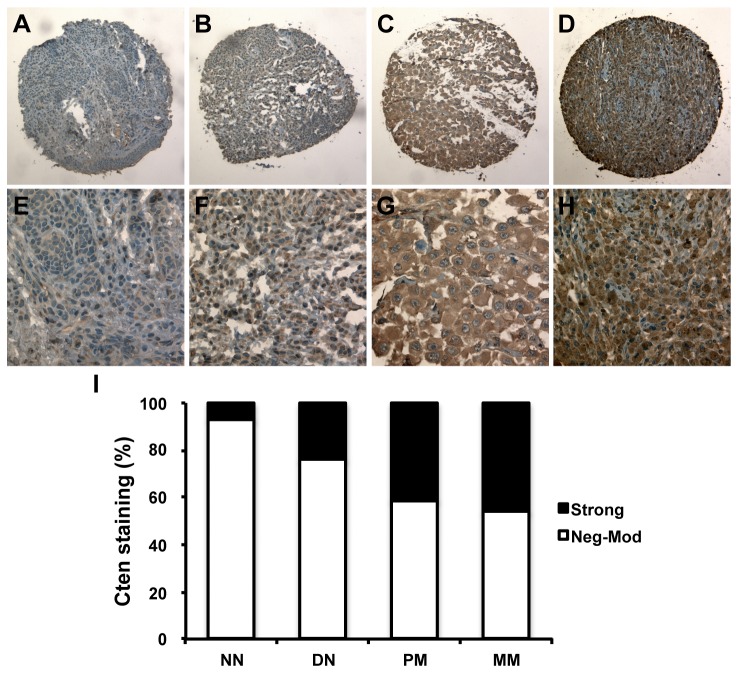
Representative images of Cten protein expression at 100x (A-D) and 400x magnification (E-H).(A, E) Weak Cten staining in normal nevi (NN). (B, F) Moderate Cten staining in dysplastic nevi (DN). (C, G) Strong Cten staining in primary melanoma (PM). (D, H) Strong Cten staining in metastatic melanoma (MM). (I) Correlation between Cten expression and melanoma progression.